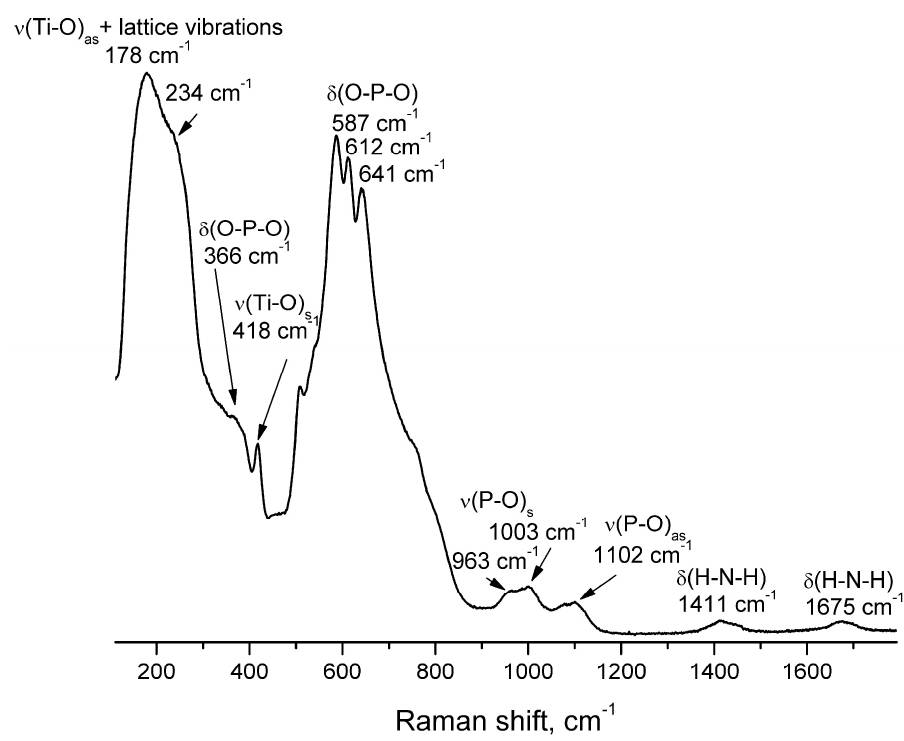
Figure 2. Raman spectrum of Ti 2 O 2 H(PO 4 )[(NH 4 ) 2 PO 4 ] 2 prepared by hydrothermally treating titanium lactate at 180 °C in the presence of urea and phosphate ions with a Ti:P ratio of 1:4 (sample TiP4). Bands were assigned according to [25,26].